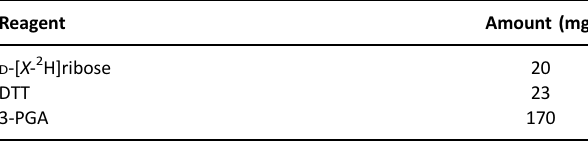
Table 9. Reagents for ATP, GTP, and UTP